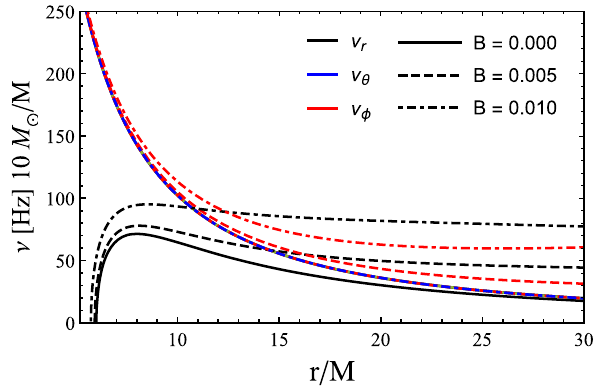
Fig. 6 Plot showing the epicyclic frequencies as a function of r / M in the case with a neutral particle. Radial, latitudinal and orbital fre- quencies are plotted for various combinations of magnetic field param- eter B . Note that solid lines refer to the epicyclic frequencies for the Schwarzschild black